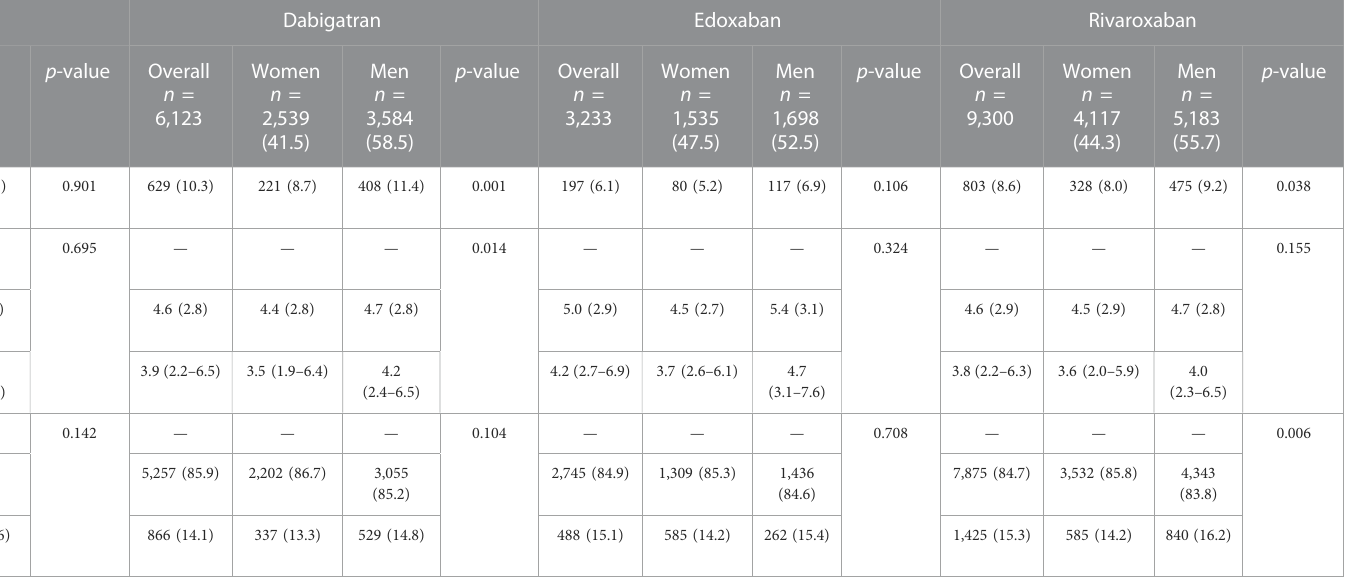
TABLE 3 Discontinuation and adherence to direct oral anticoagulants.